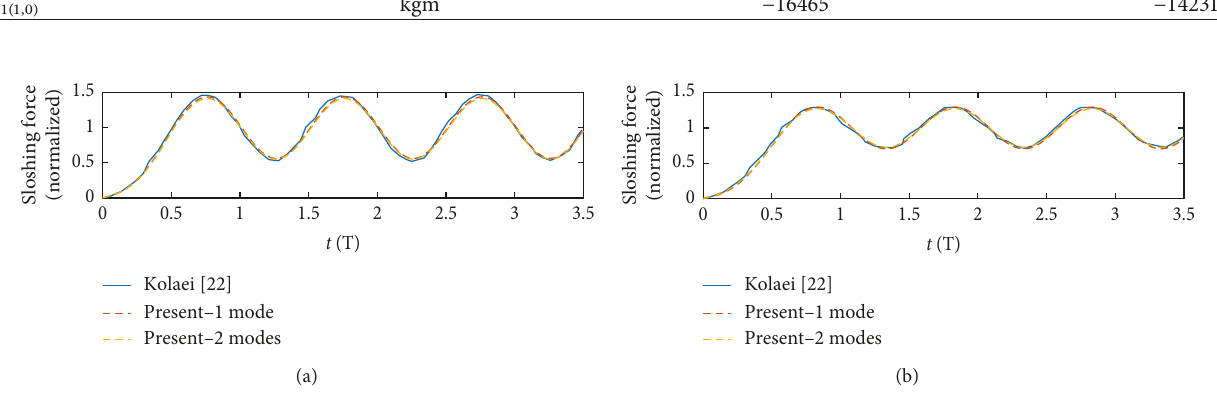
Figure 6: Comparison of sloshing forces: (a) h